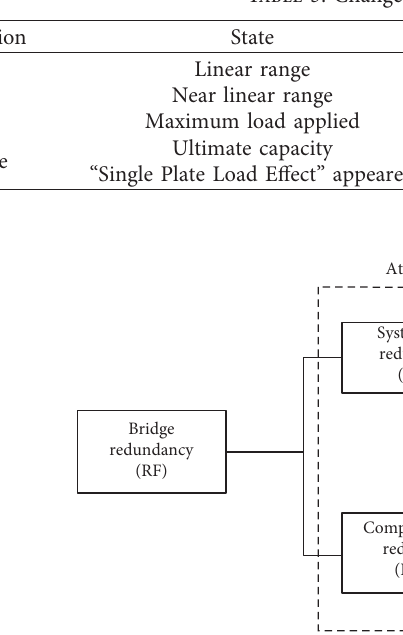
Figure 15: Redundancy and robustness of an adjacent box beam